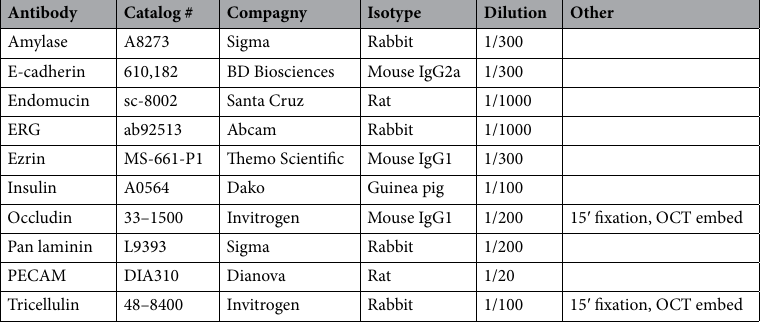
Table 1. Immunofluorescence